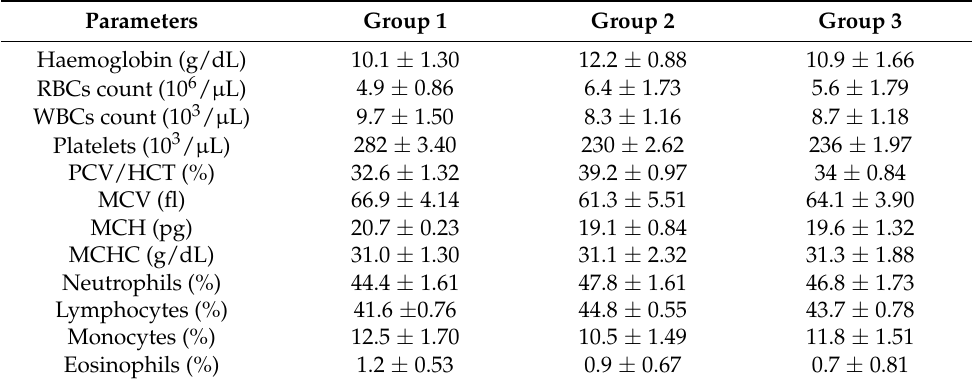
Table 5. Hematological Analysis of rabbit (Mean ± SD, n = 5).